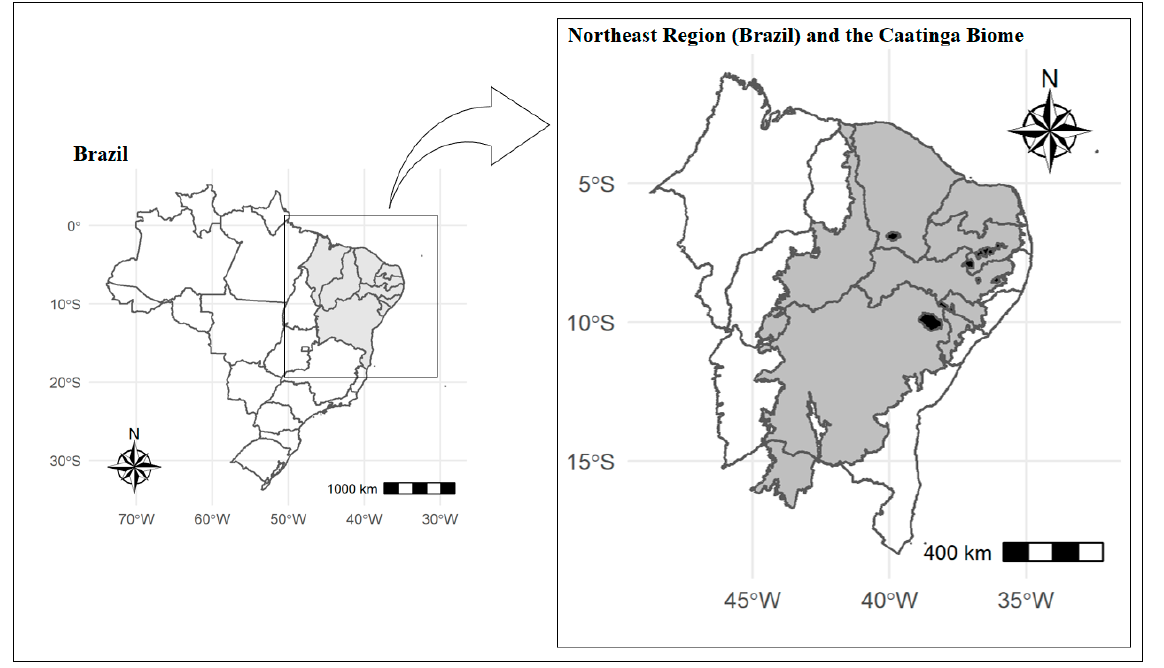
Figure 4. Regions of the Ethnobotanical Surveys (black) conducted in Brazil, with emphasis on the Caatinga Biome (gray).